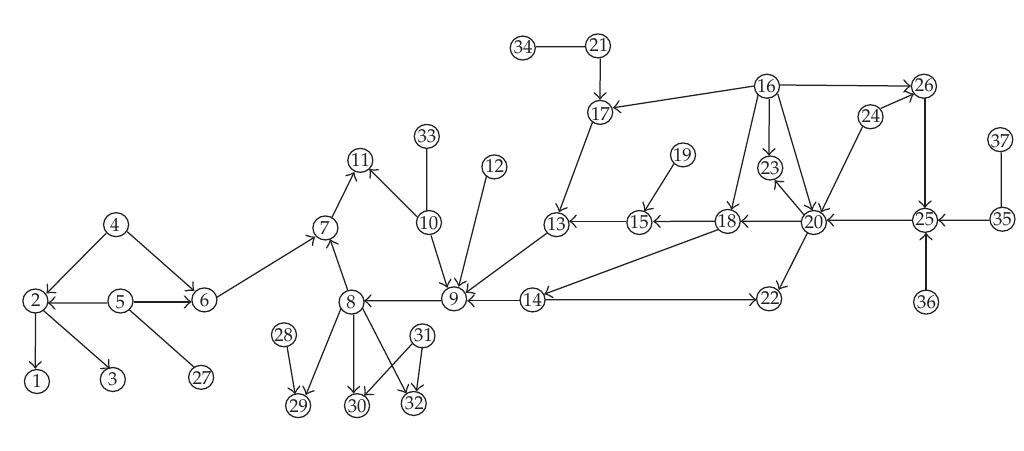
Figure 6: The partially directed acyclic